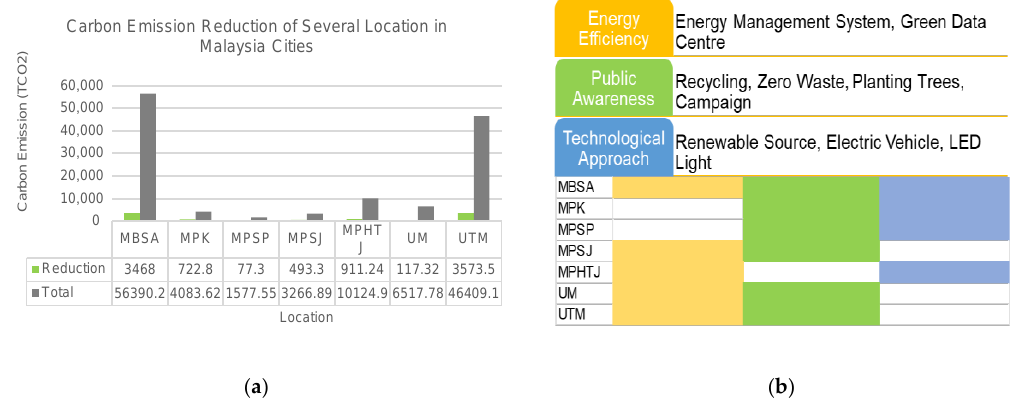
Figure 4. ( a ) Carbon emission reduction of several locations in Malaysian cities; ( b ) Categorization of activities/initiatives conducted according to the respective location [43].